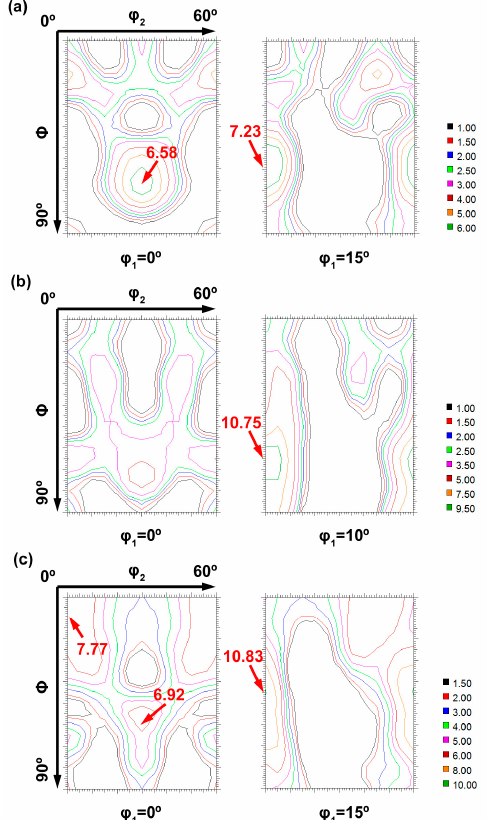
Figure 6. Representation of ODF sections at constant φ 1 corresponding to IA states: ( a ) as-received + IA state: φ 1 = 0° and φ 1 = 15°; ( b ) 30% warm-drawn + IA state: φ 1 = 0° and φ 1 = 10°; ( c ) 60% warm-drawn + IA state: φ 1 = 0° and φ 1 = 15°.